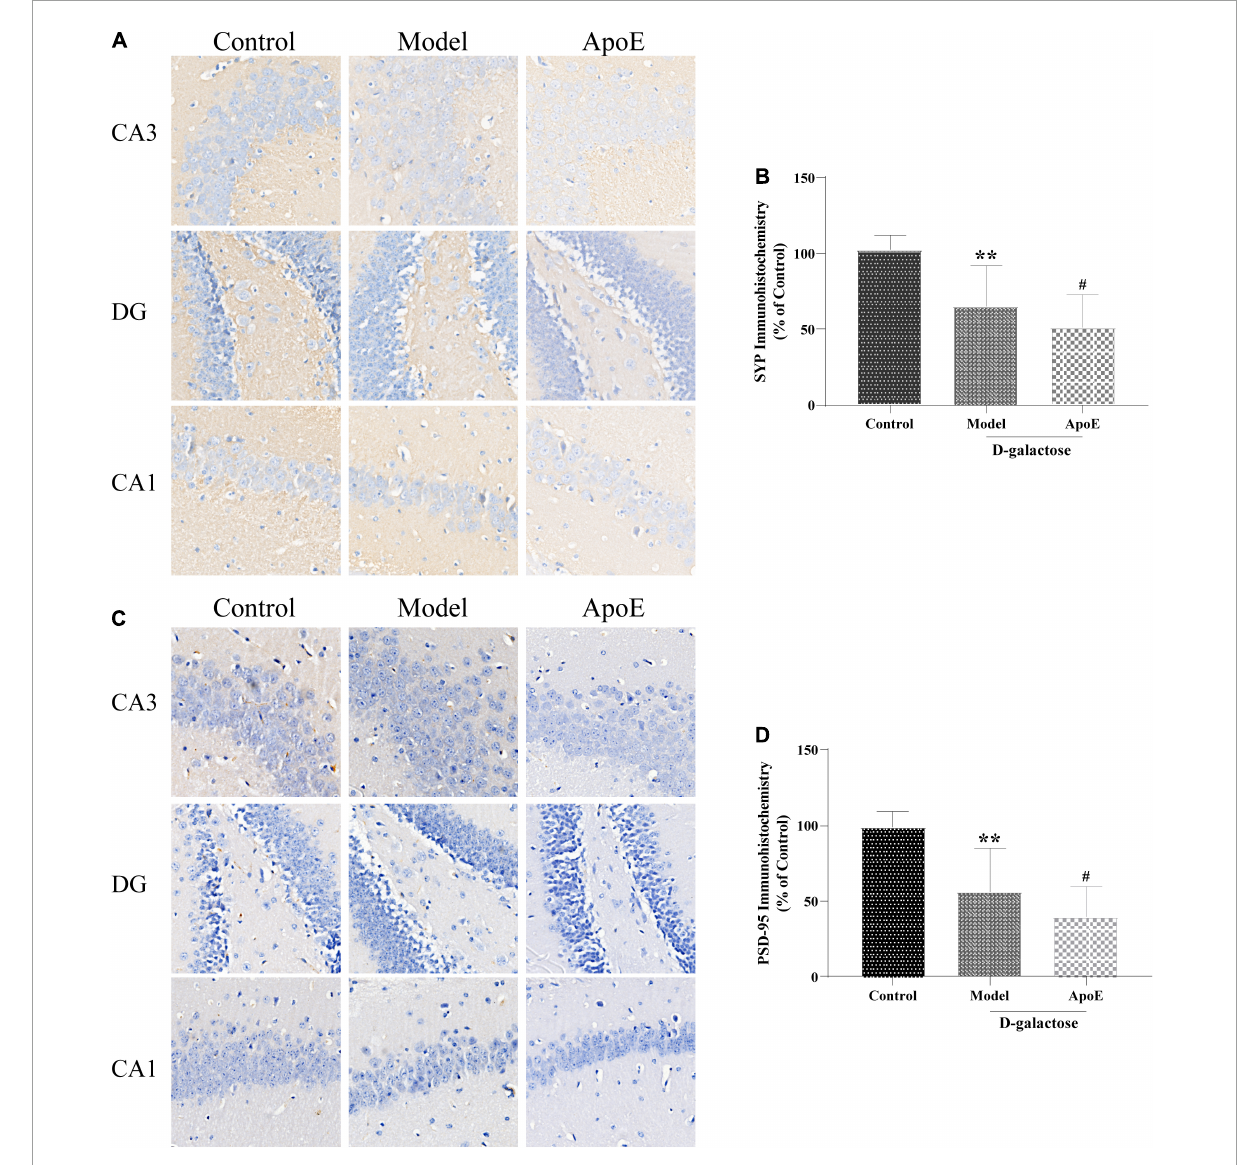
FIGURE3 ApoE Deletion aggravates the dysregulation of SYP and PSD-95 expression in the hippocampus of aging mice. (A) Immunohistochemistry staining for SYP in different hippocampal regions. (B) Quantification of SYP intensity, n = 8. (C) Immunohistochemistry staining for PSD-95 in different hippocampal regions. (D) Quantification of PSD-95 intensity, n = 8. ** p < 0.01 vs. Control group, # p < 0.05 vs. Model